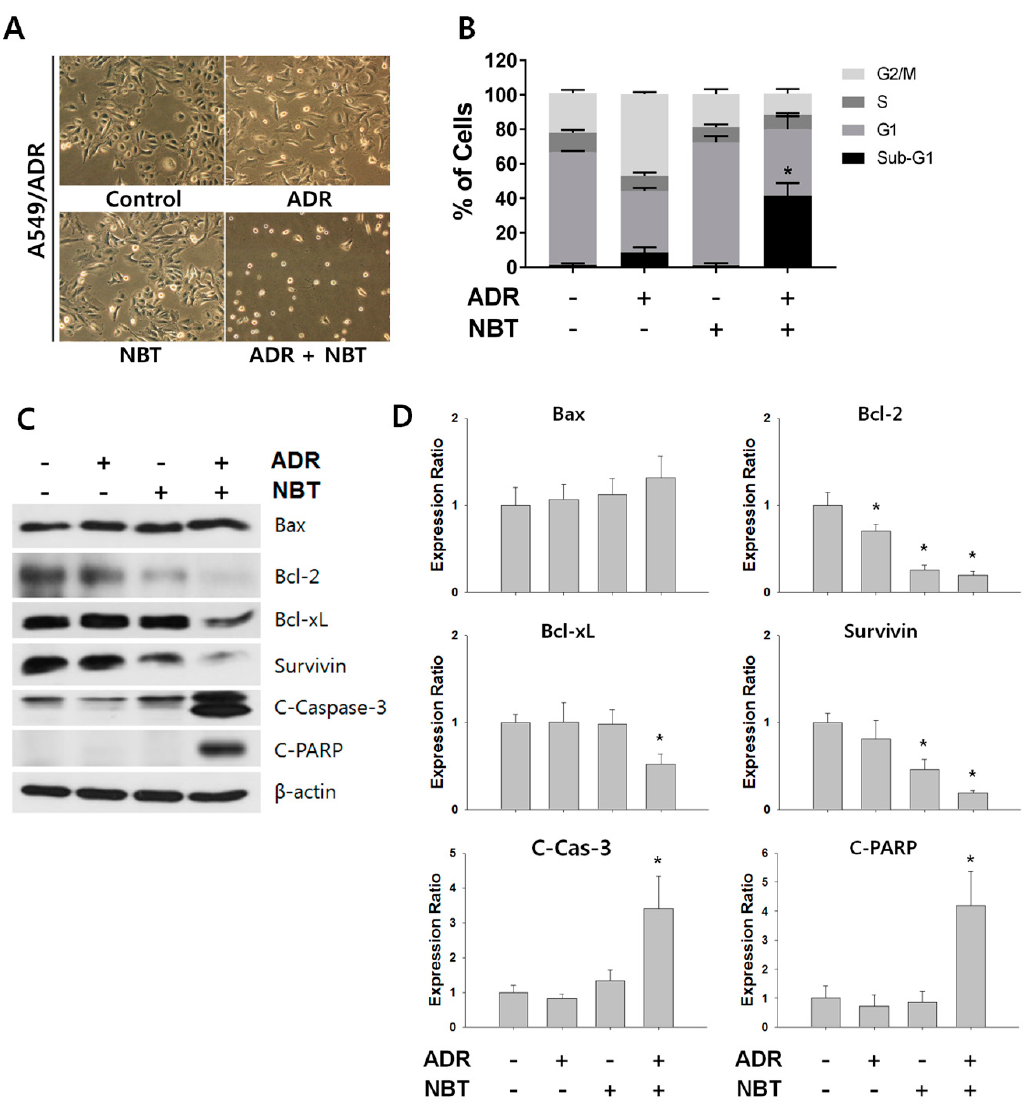
Figure 7. NBT enhances the apoptosis-initiating potential of ADR in A549/ADR cells. ( A ) Morphological features of A549/ADR cells after treatment with ADR (0.5 µ M), NBT (50 µ M), or both. ( B ) A549/ADR cells treated with ADR alone (0.5 µ M), NBT alone (50 µ M), and a combination of both were subjected to cell cycle analysis by flow cytometry using propidium iodide (PI) staining. ( C ) Expression levels of proteins were analyzed by Western blotting. β -actin was used as an internal control. ( D ) The intensities of the Western blotting bands were quantified using ImageJ software. * p < 0.05.